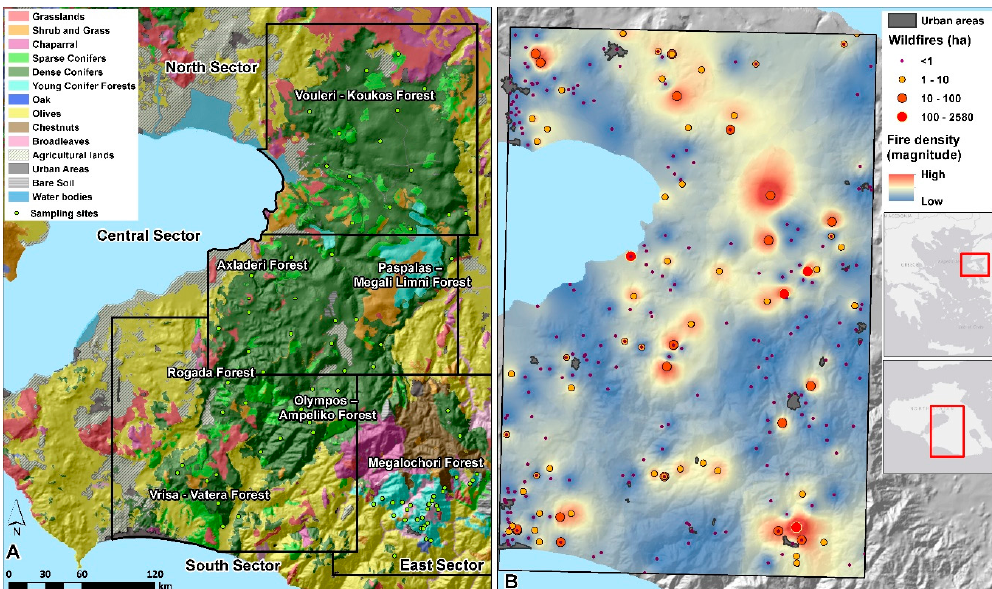
Figure 1. ( A ) Land cover types and forest sectors of the study area; ( B ) wildfire events and fire density based on the magnitude of the event (in hectares), estimated with the inverse distance weighting interpolation for the period